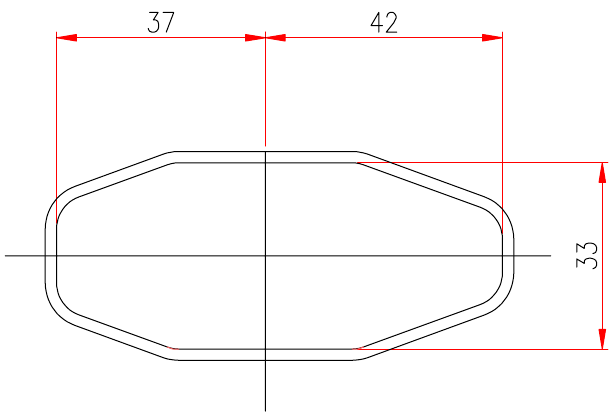
FIG. 2. (Color) Cross section of the standard vacuum chamber of the storage ring.